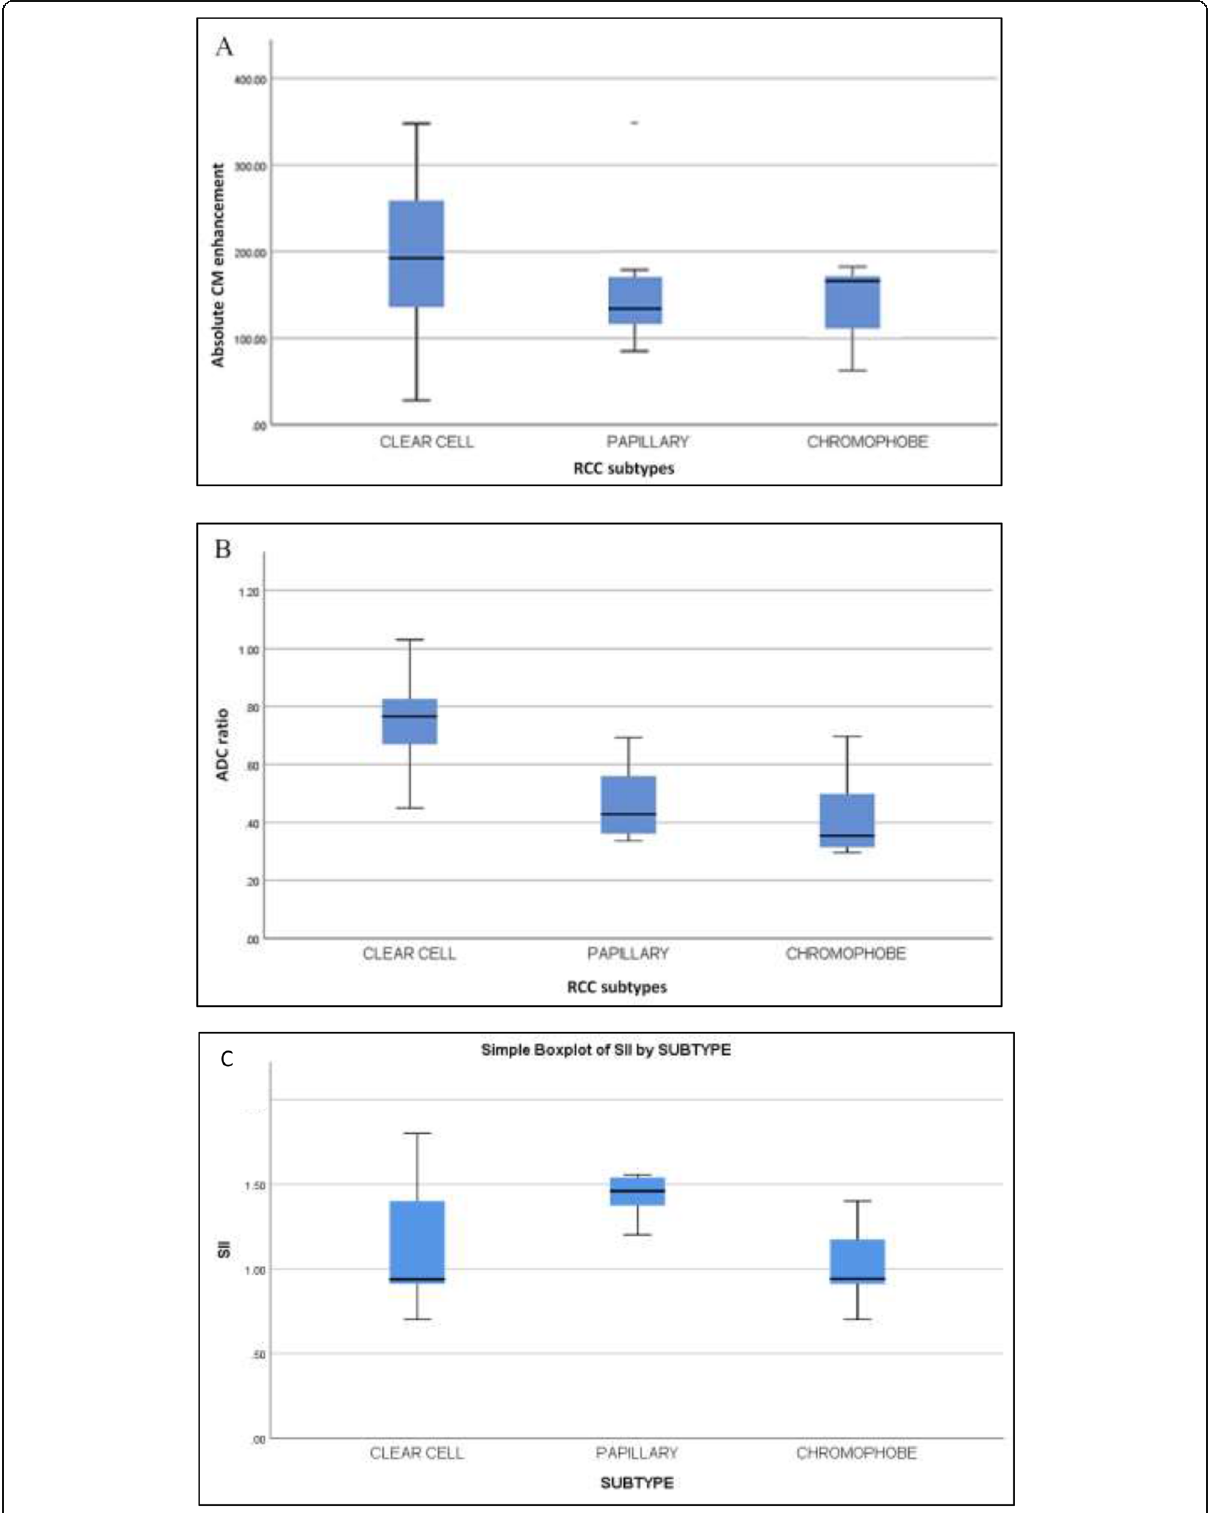
Fig. 1 Box plots show multiparametric quantitative evaluation of the subtypes of renal masses. a Absolute CM enhancement, b ADC ratio, and c SII are